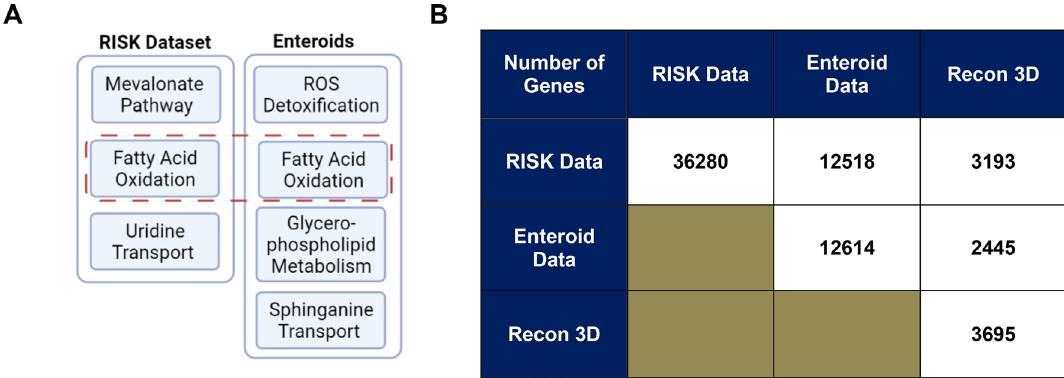
Figure 4. Overlap between gene count data and pathways with an altered flow in the RISK dataset and enteroids: ( A ) Overlap between the reaction "families" that were found to be altered in the RISK dataset and enteroids. After conducting in silico RIPTiDe studies and performing random forest analysis, reactions involved in fatty acid oxidation were found to be altered in both the RISK dataset and the enteroids as detailed in Table 1. ( B ). Gene overlap between the RISK cohort and the ileal organoids- "enteroids." Gene count analysis showed that 99% of the genes present in enteroids were also present in the RISK dataset. Only 96 genes were found to be unique to the